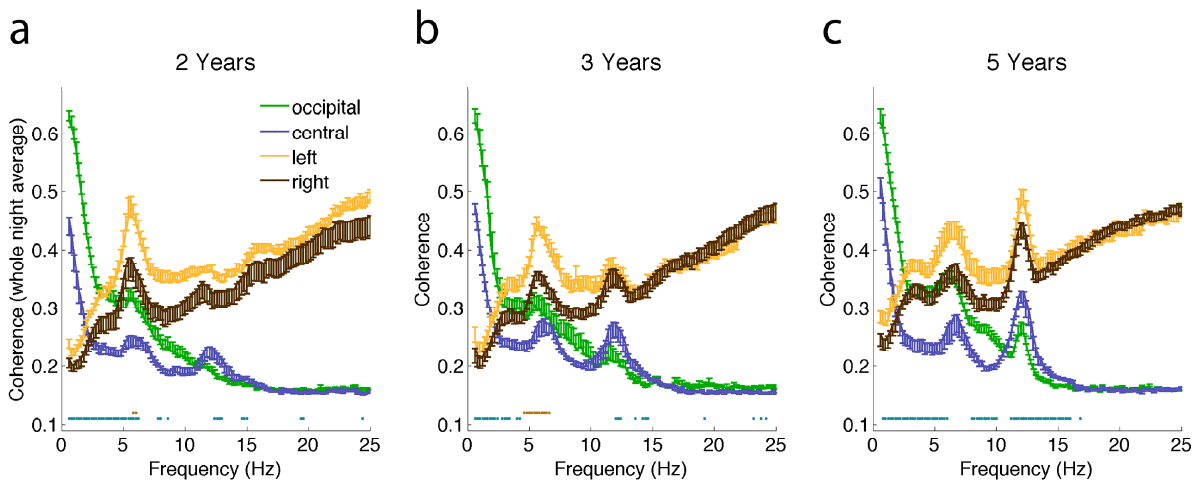
Figure 2. Average all-night coherence spectra [non-rapid eye movement (non-REM) sleep stages N2–N4, artifact free epochs only]. Dots refer to significant differences between inter-hemispheric coherence spectra (occipital vs. central, green ), and intra-hemispheric coherence (left vs. right hemisphere, brown ) using bootstrap statistics for each 0.2 Hz bin ( p < 0.05). Fisher’s z -transformation was applied to the square root of coherence values for statistical analysis. Back-transformed, squared data are plotted (applies for all subsequent figures). ( a ) 2 Years; ( b ) 3 Years; and ( c ) 5 Years.